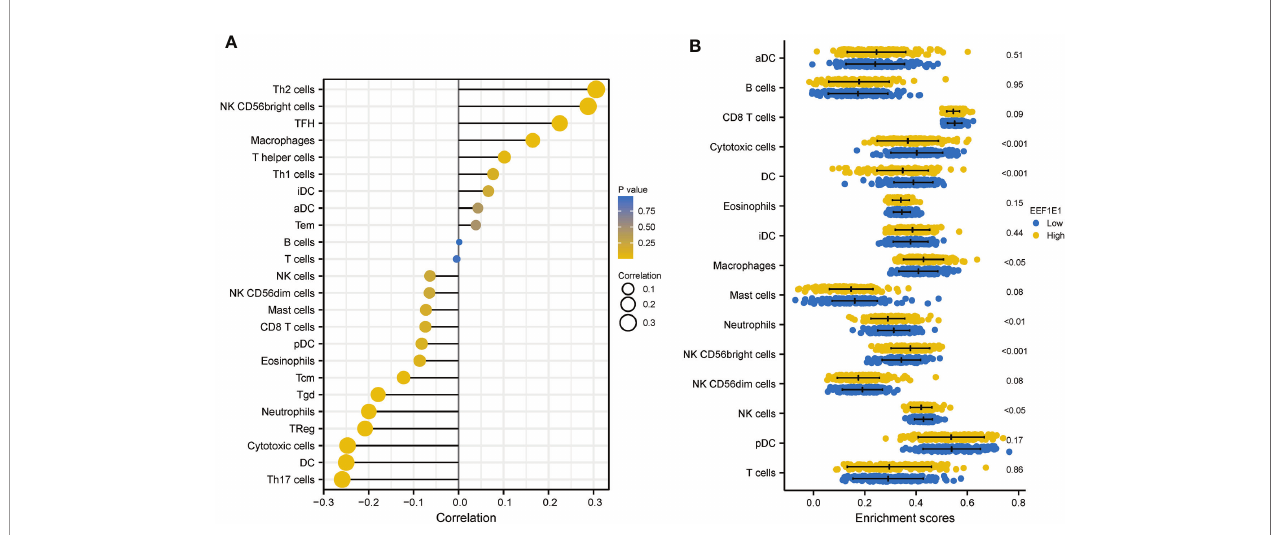
FIGURE 6 | Correlation between expression of EEF1E1 and immune in fi ltration. (A) Correlation between expression of EEF1E1 and immune cells in fi ltration. (B) Effect of differential EEF1E1 expression on immune cells in fi